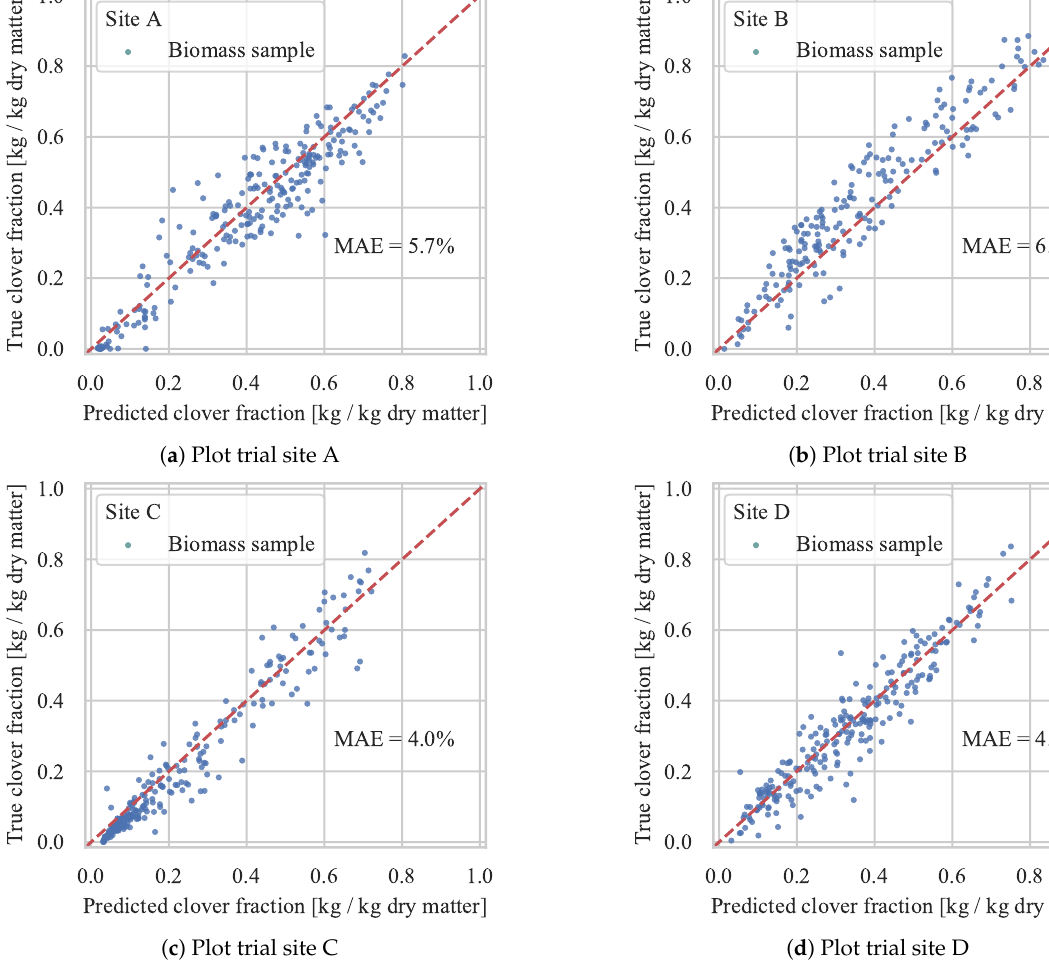
( d ) Plot trial site D